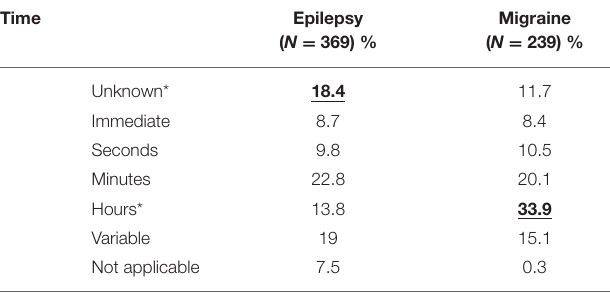
Frontiers in Neurology |